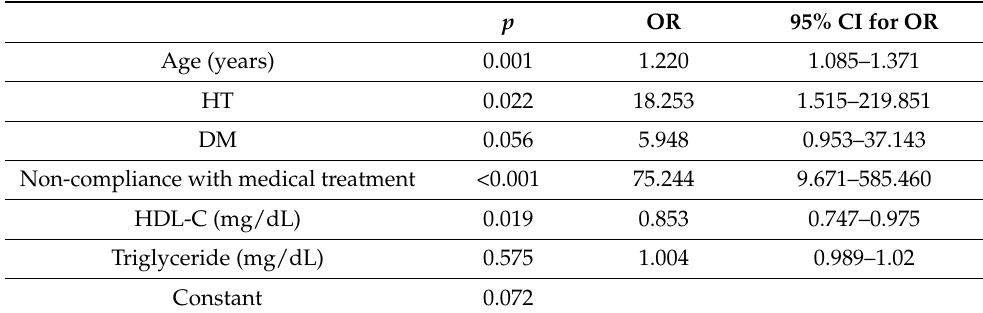
Table 3. Multiple logistic regression model for total mortality in patients with CSF.